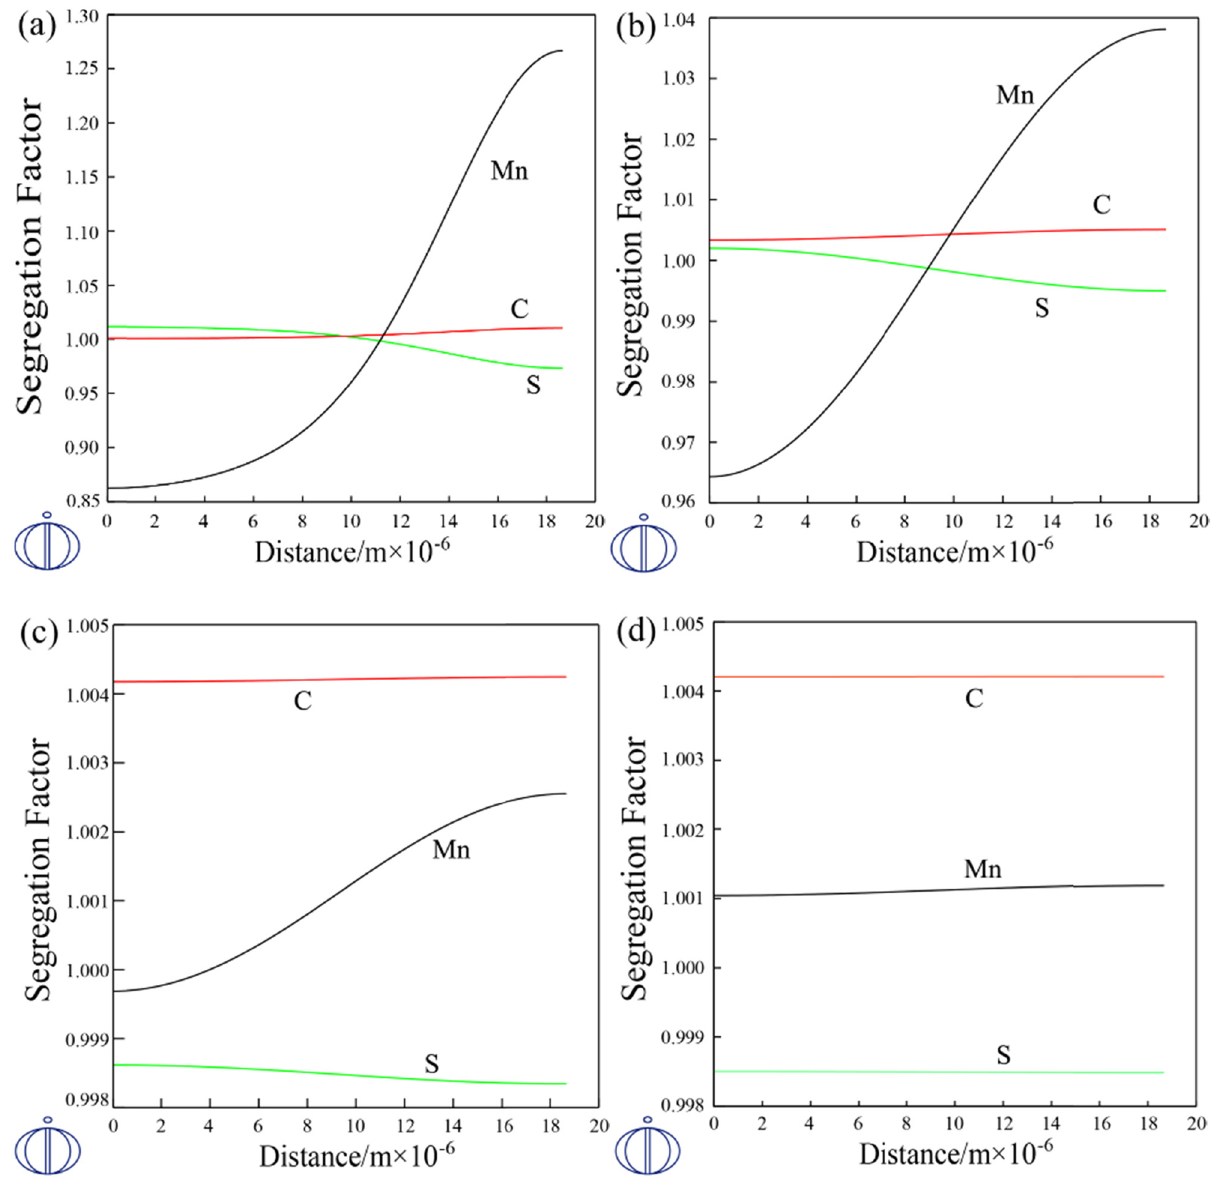
Figure 13: Variation of segregation factor of main element in as - cast steel along with homogenization time ( a ) as - cast, ( b ) 1 h, ( c ) 3 h, ( d ) 5